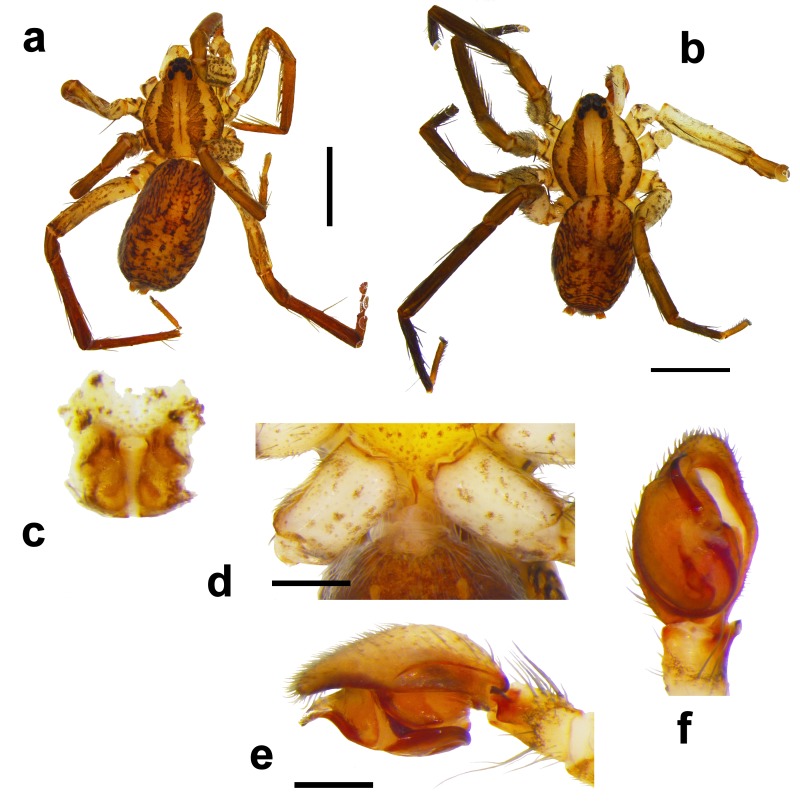
Zora
silvestris Kulczynski, 1897. a: female, dorsal habitus, scale = 2 mm; b: male, dorsal habitus, scale = 1 mm; c: female epigynum, ventral, scale = 0.2 mm; d: male coxae IV (no special setae), ventral, scale = 0.4 mm; e: left male palp, retrolateral, scale = 0.2 mm; f: left male palp, ventral, scale = 0.2 mm.